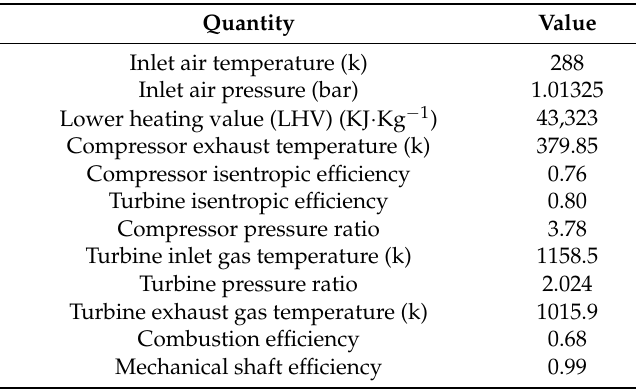
Figure 2. Schematic of the JetQuad jet engines and the developed bond graph model. Table 2. JetQuad specifications.